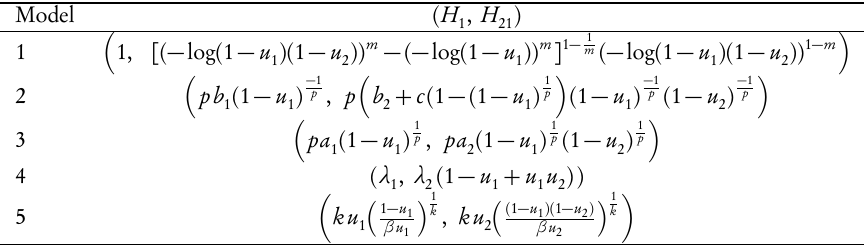
Bivariate hazard quantile functions of lifetime distributions in Table